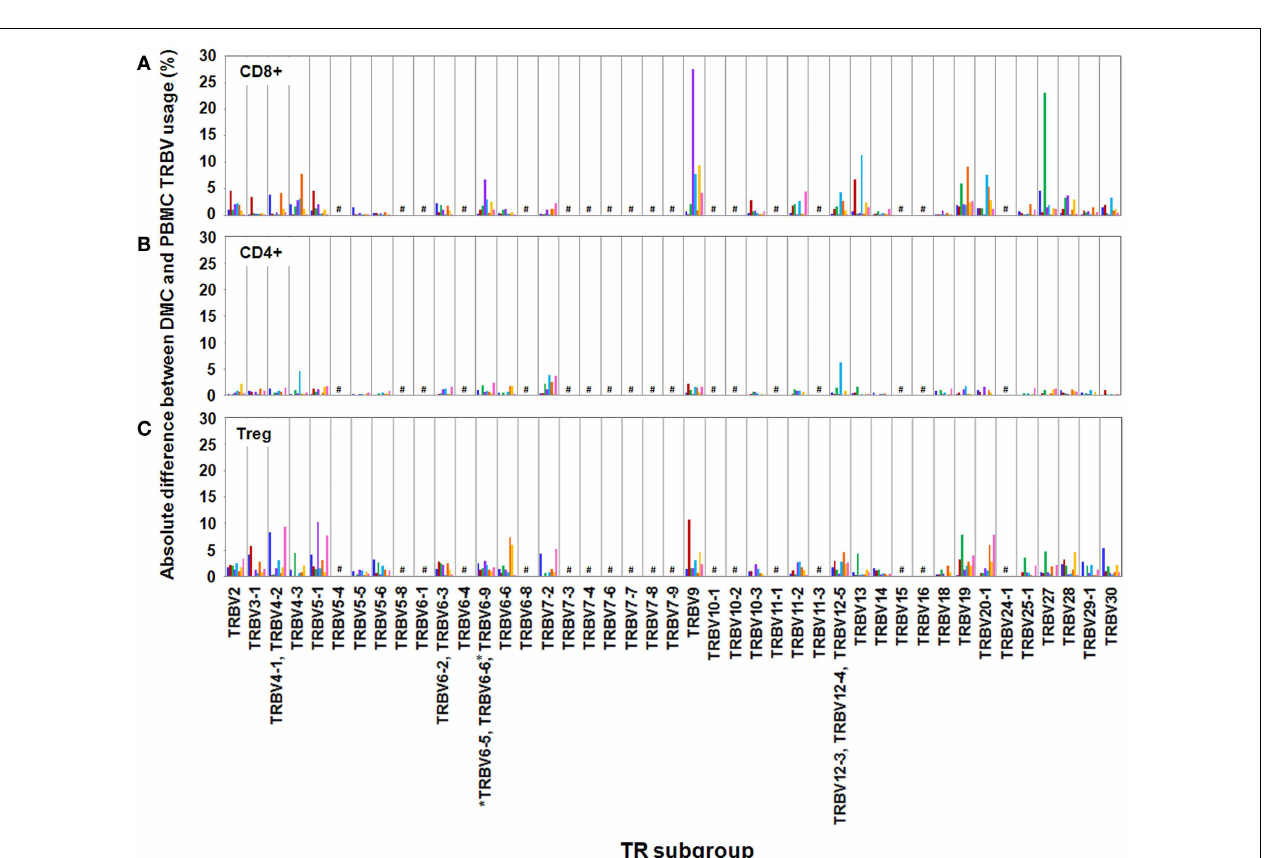
encodingTRBV for which no antibody was included or available are indicated by a #.TRBV gene names are according to the IMGT nomenclature (13, 14). *Although clone IMMU 222 has previously thought to recognizeTRBV6-6, in addition toTRBV6-5 andTRBV6-9 (15), our data suggest that IMMU 222 is not TRBV6-6-specific, as dual staining was not observed using both IMMU 222 and JU74.3